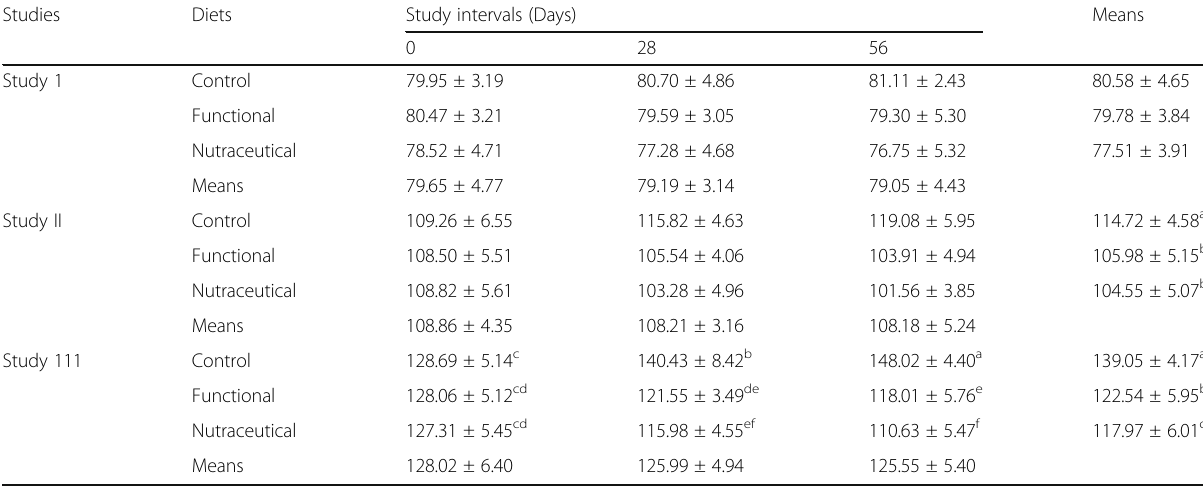
Table 4 Effect of diets and study intervals on cholesterol (mg/dL) of rats in different studies Studies Diets